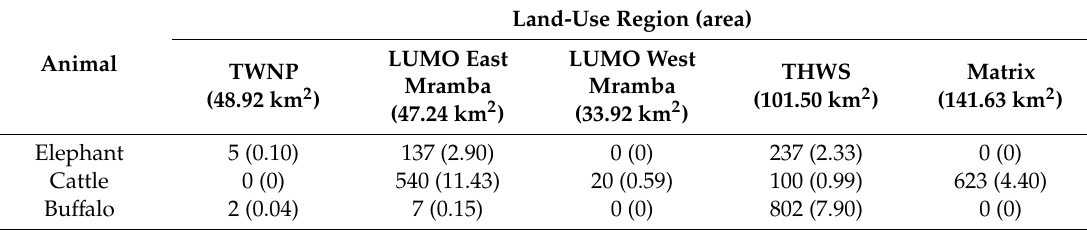
Figure 4. Biomass map showing the boundaries of the land-use regions: Taita Hills Wildlife Sanctuary (THWS), LUMO Community Wildlife Sanctuary (LUMO East Mramba, LUMO West Mramba, and LUMO Oza), Tsavo West National Park (TWNP), and other land use (matrix), and animal counts for elephants, buffalos, and cattle in 2014. Table 2. Animal counts (animals) and densities (animals/km 2 ) per land-use region during the 2014 wildlife census by Kenya Wildlife Service. Land-use regions: Taita Hills Wildlife Sanctuary (THWS), LUMO Community Wildlife Sanctuary (LUMO East Mramba and LUMO West Mramba), Tsavo West National Park (TWNP), and other land use (matrix).